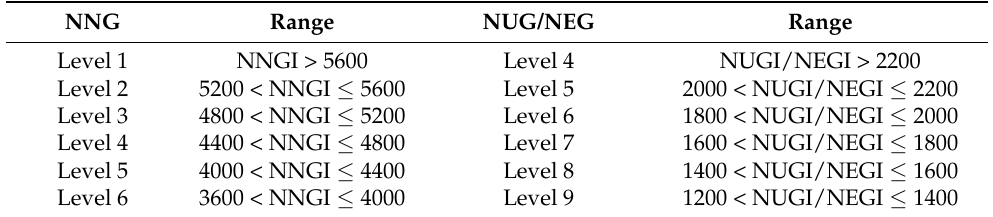
Table 3. Classification standard of cultivated land